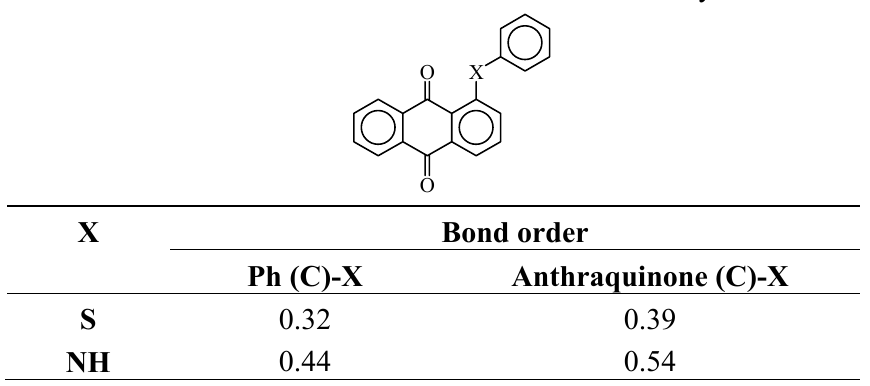
Table 6. The bond orders of C-N and C-S bonds calculated by PPP-CI